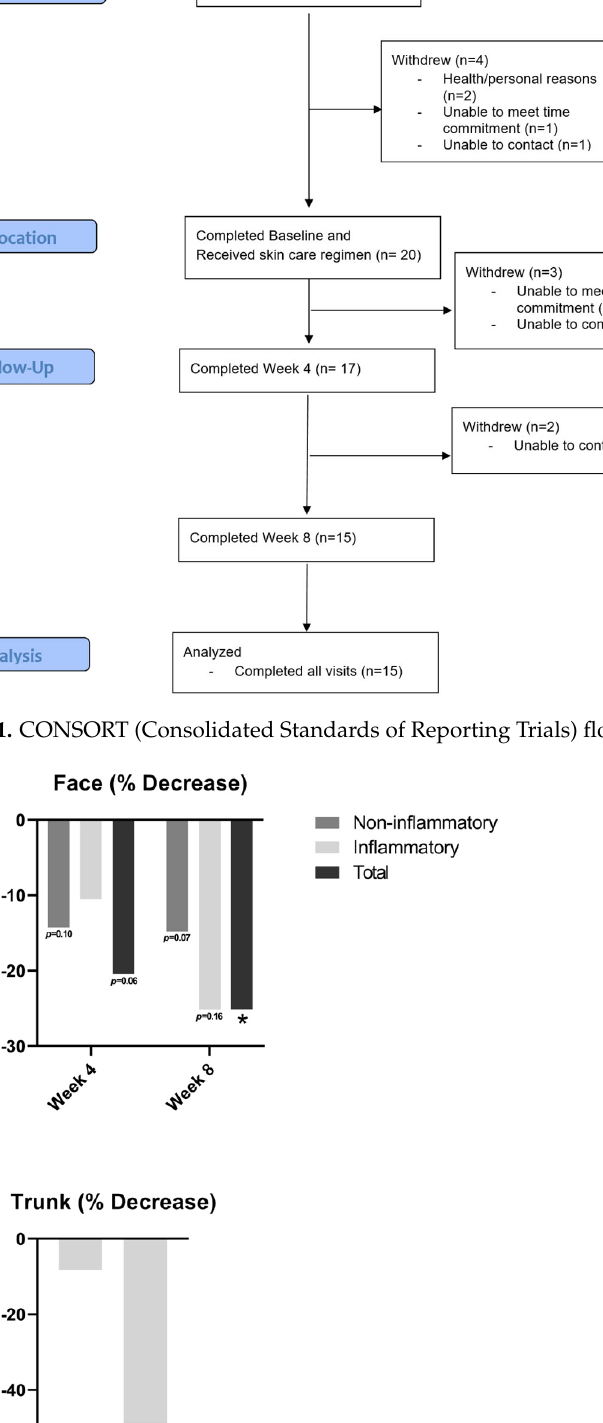
Figure 3. Acne photographs from a representative participant at baseline, week 4, and week 8. 3.2. Sebum Excretion Rate The sebum excretion rate was found to have a decreasing trend on the forehead at both follow-up visits relative to baseline (Figure 4). From baseline to week 4, the average percent change was nearly a 40% reduction on the forehead ( p = 0.07) and nearly a 35%